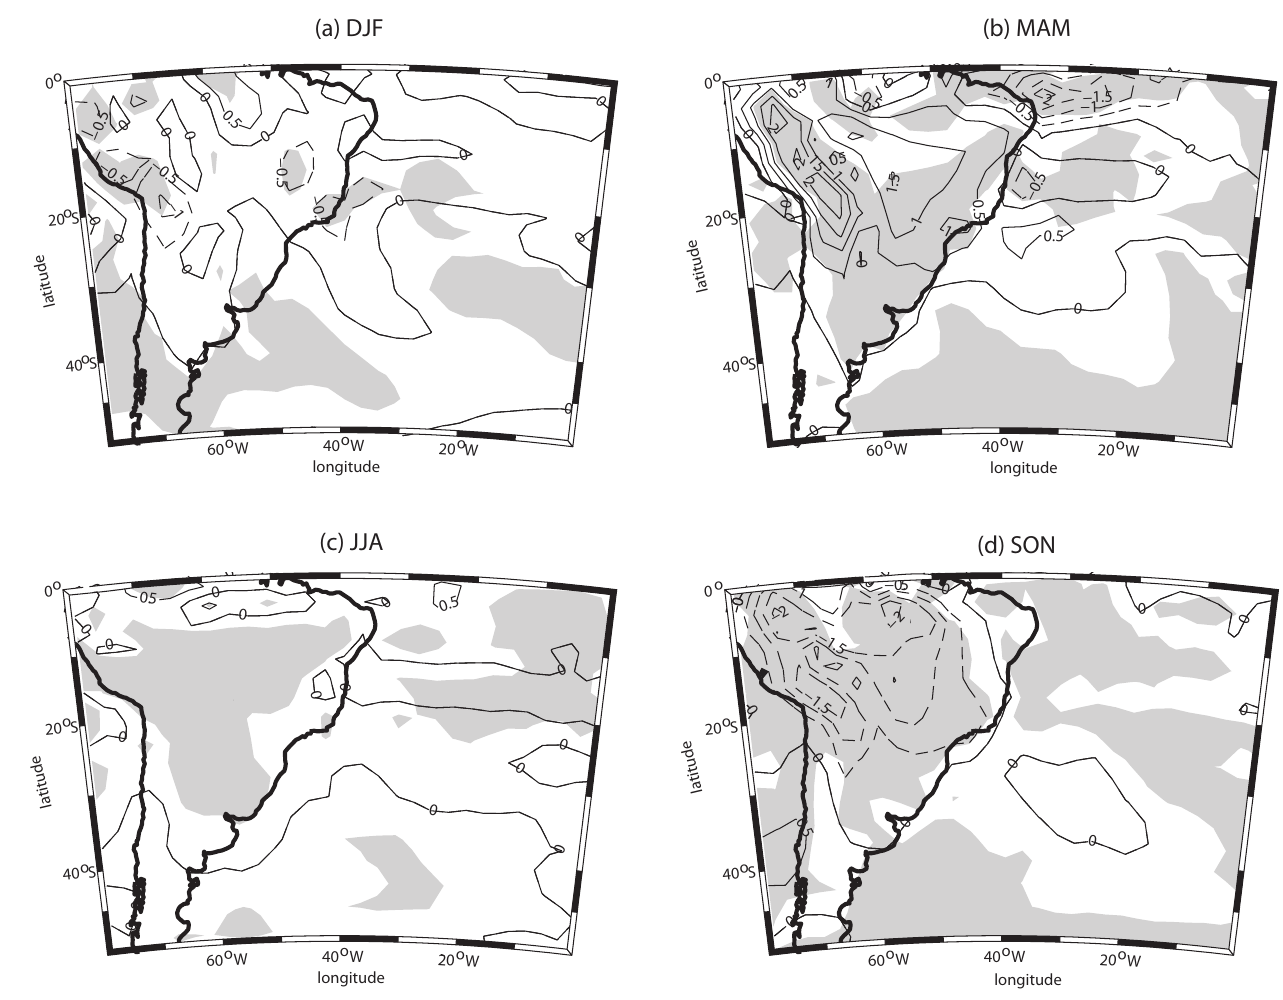
Fig. 2. Difference of the seasonal mean precipitation between EXP1 and EXP2. Positive (negative) rainfall indicates an overestimate (underestimate) from EXP2 to EXP1. Contour interval is 0.5mmday − 1 . Shading represents areas where EXP2 is statistically different from EXP1 at the 95% level according to a t-student test. (a) DJF, (b) MAM, (c) JJA and (d)